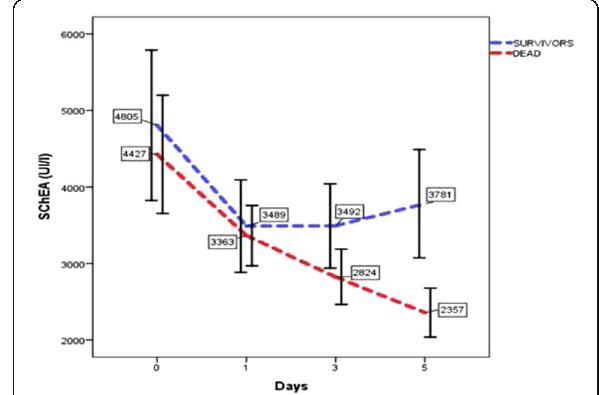
Fig. 1 (abstract 0123). SChEA's kinetic in dead and survivor patients on the day of admission then on 1st, 3rd and 5th days of septic shock